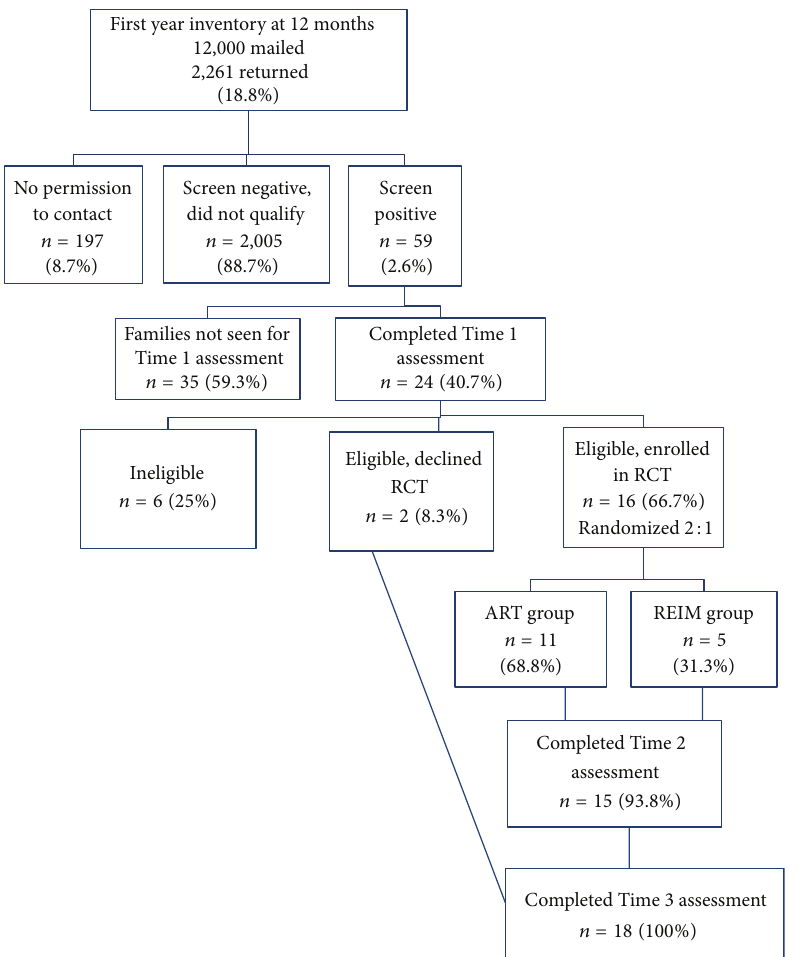
Figure 1: Study flow chart with participation rates for each